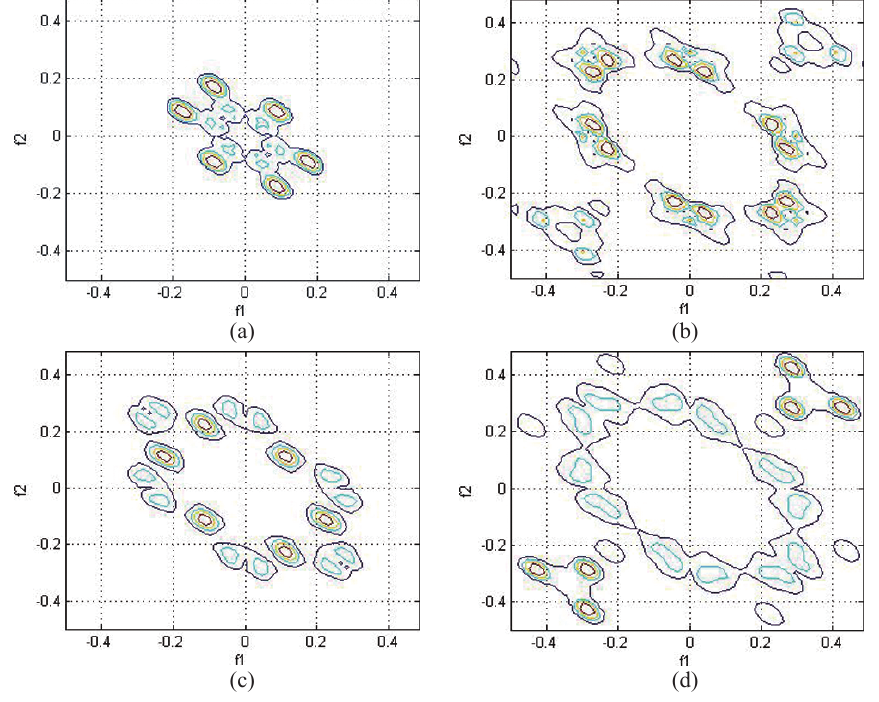
Fig. 1. Bispectrum feature images of different faults (a) Normal state (b) Outer fault (c) Inner fault (d) Roller